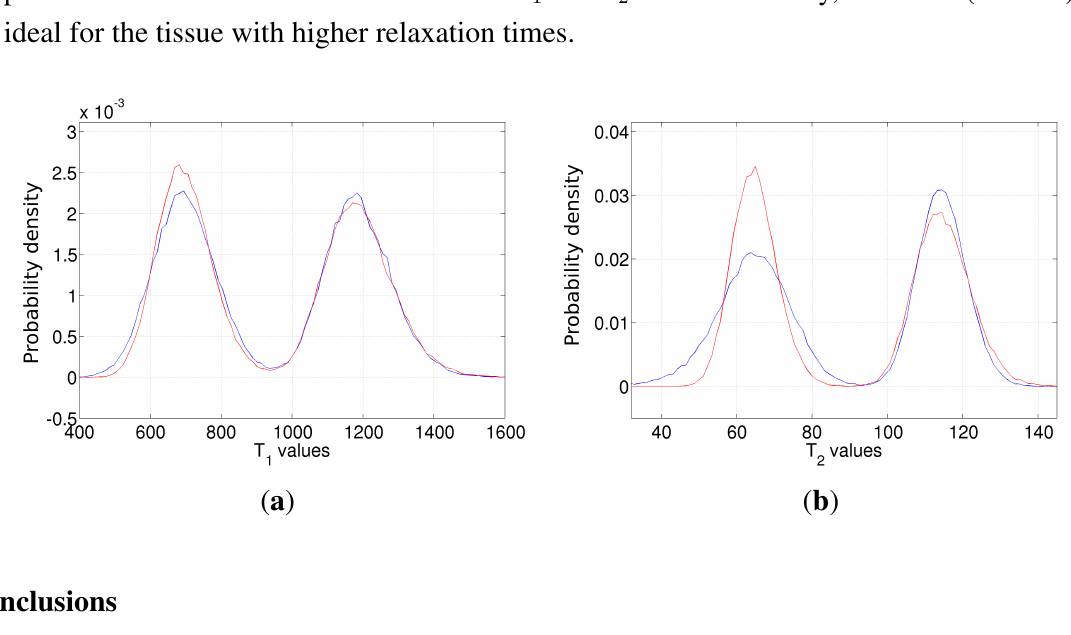
( a ) and T ( b ) estimators 1 2 and T . On the contrary, Dataset 2 (red line) is 1 2